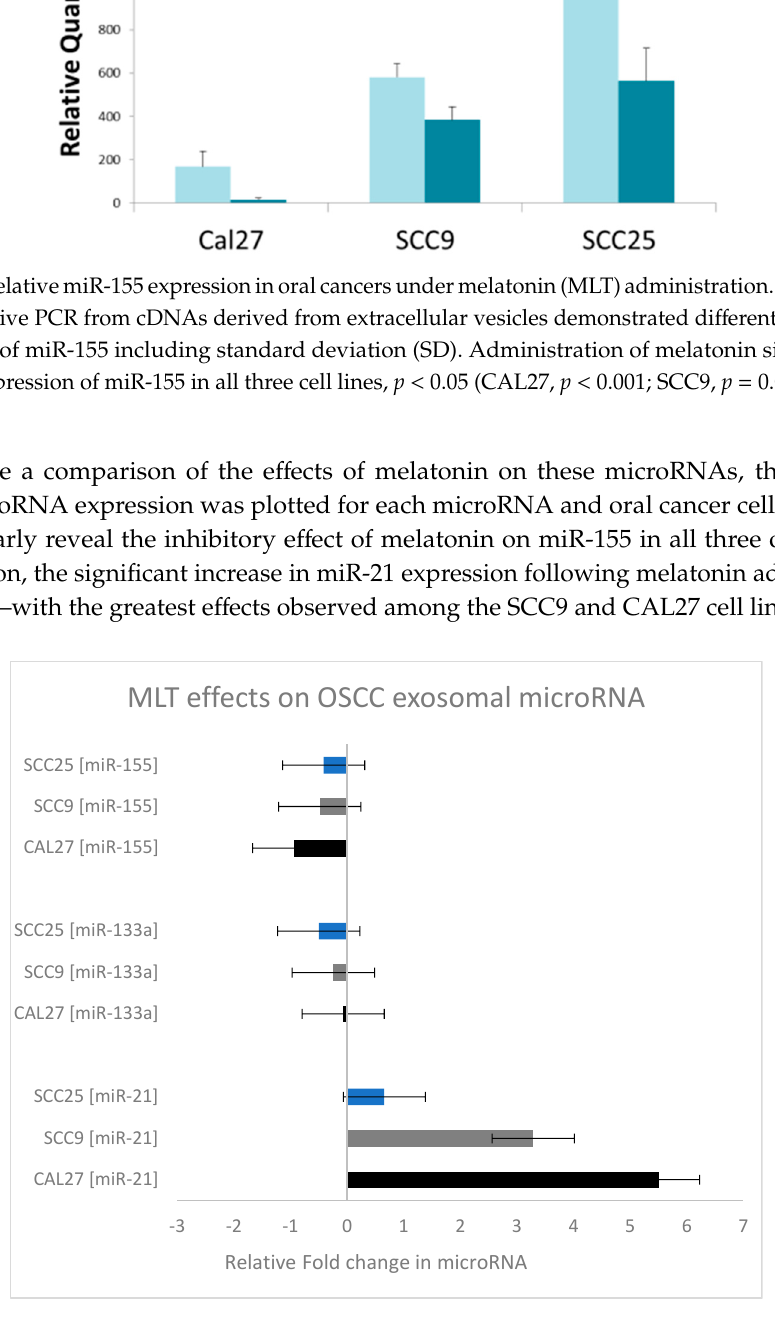
Figure 4. Relative fold change in microRNA expression in oral cancers under melatonin (MLT) administration. Calculation of the relative fold change in miRNA expression (experimental/baseline control) revealed significant increases in miR-21, with relatively little change to miR-133a and some inhibition of miR-155 (particularly in the CAL27 cells).